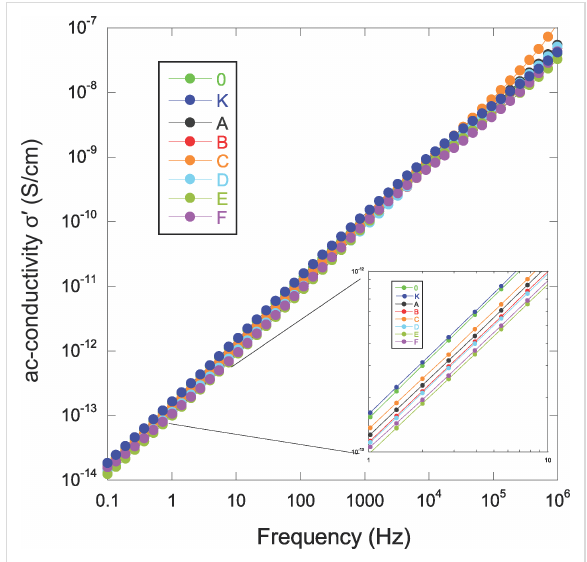
Figure 9: Electrical conductivity of pure parylene C and NCPCs.